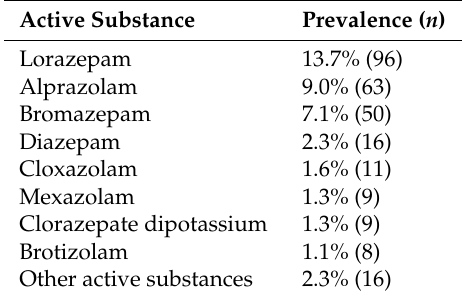
Table 1. Use of prescribed active substances among benzodiazepine users.